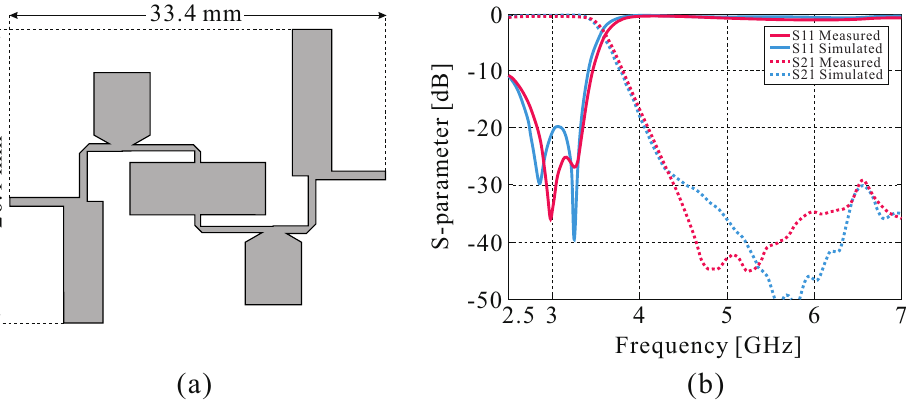
Figure 4. Proposed filter and the S-parameter. ( a ) A microstrip line model of the proposed filter optimized for the antenna base and ( b ) the simulated